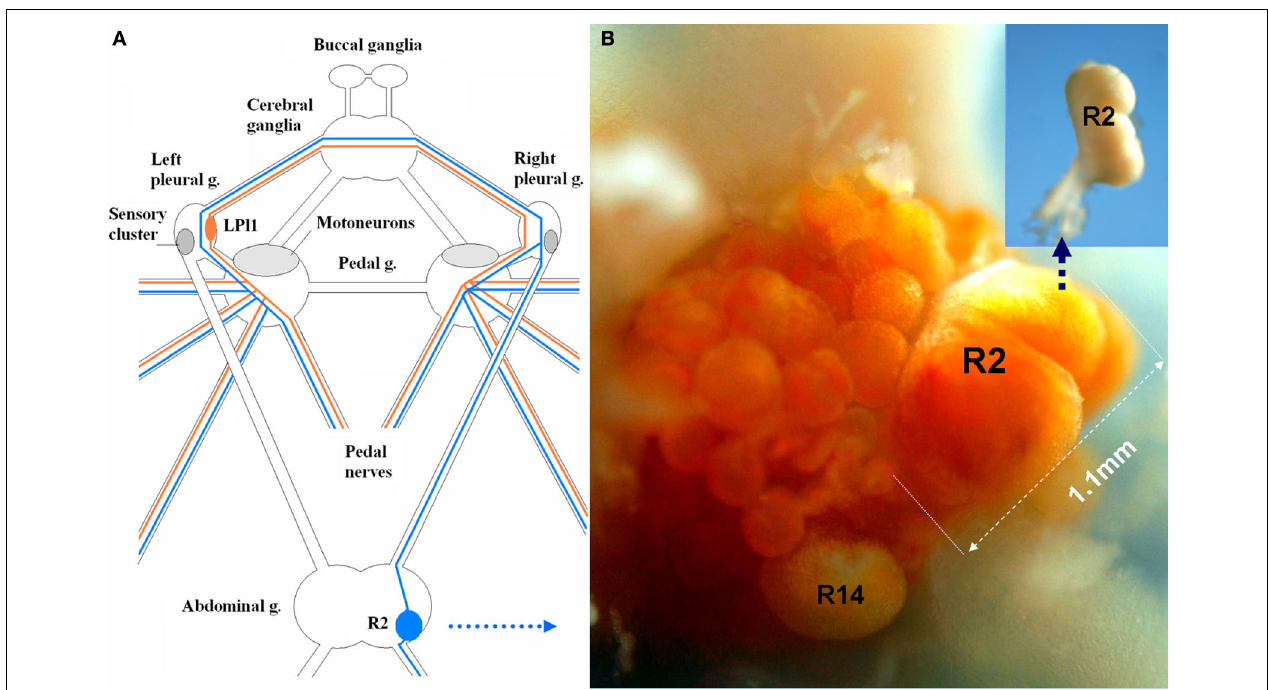
FIGURE 2 | Indentifi ed motor neurons (LPl1 and R2) in Aplysia are among the largest somatic cells in the animal kingdom. (A) A schematic diagram of the central ganglionic nervous system of Aplysia with positions of two giant neurons (LPl1 and R2), mechanosensory pleural neurons (SN) and motor pedal neurons. LPl1 is located in the left pleural ganglion (red lines represent major axonal branches) and R2 in the abdominal ganglion (blue lines represent major axonal branches). Both the positions of these neurons and their axonal pathways are highly conserved across individuals, and these cells can be reliably identifi ed in closely related species of the genus Aplysia (modifi ed